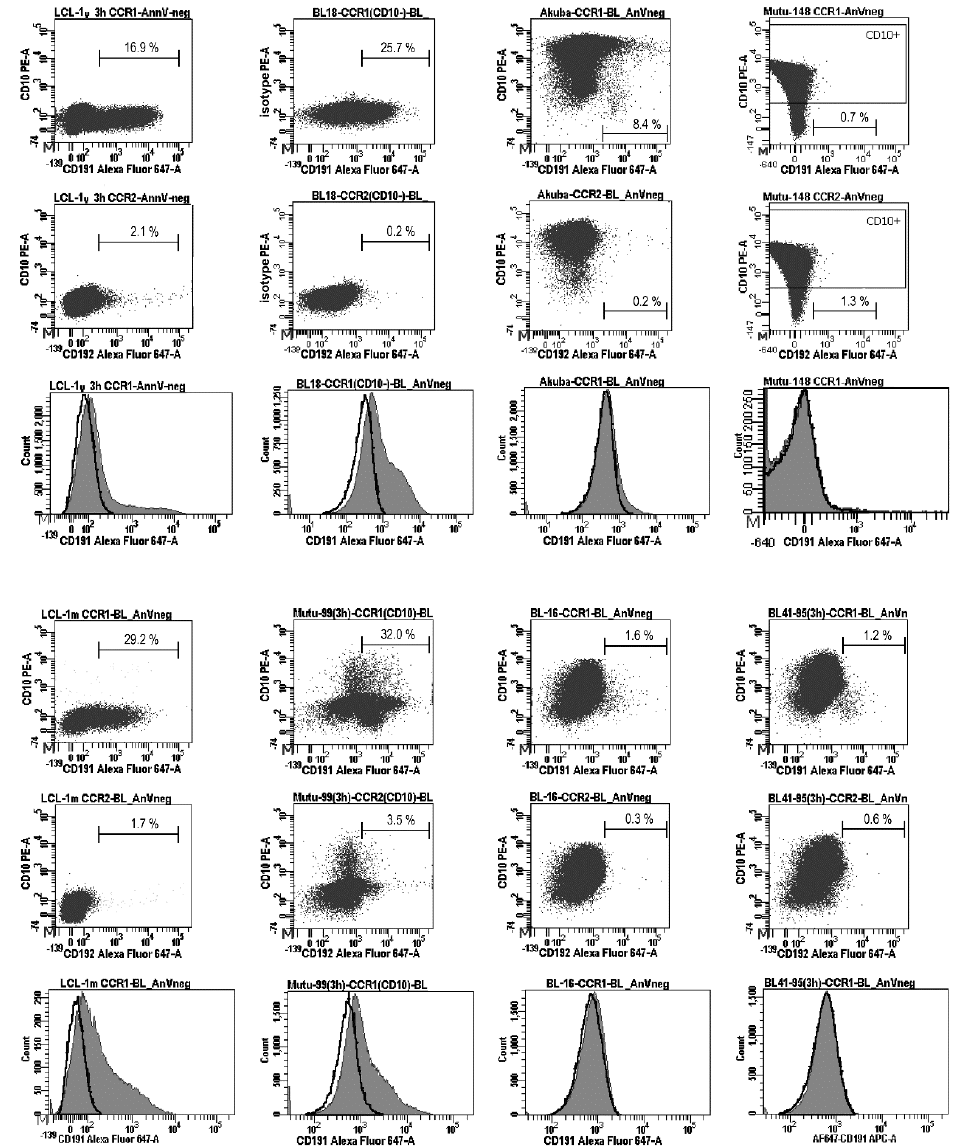
Figure 3. Analysis of the CCR1 cell surface expression in Burkitt lymphoma cell lines. The presence of CCR1 on the cell surface was analyzed after inducing receptor recycling (3 h of serum deprivation), using three-color flow cytometry. BL18 and Mutu cl.99 are the EBV-carrying type III BL cell lines; Akuba, BL41/95, and BL16 are the EBV-carrying type II BL cell lines; Mutu cl.148 is the EBV-carrying type I BL cell lines; LCL-1y and LCL-1m are the established in vitro LCLs, which have been cultured during approximately 1 year and 1–2 months, respectively. The dot plots show the cells stained with anti-CD10-PE, anti-CD191(CCR1)-Alexa Fluor 647, and anti-CD192(CCR2)-Alexa Fluor 647 antibodies; a minimum of 20,000 gated cells were analyzed; the threshold border was defined at 3.0% of the stained cells. Apoptotic cells (stained with annexin V-Horizon V450 or annexin V-PerCp-Cy5.5) and autofluorescent cells were excluded from the analysis. The anti-CD192(CCR2)-Alexa Fluor 647 antibodies did not detect CCR2 on the cell surface in BL cell lines nor in LCLs. The histograms show the vast majority of the CD191(CCR1)-stained cells (filled gray) shifted relative to the CD192(CCR2)-stained cells (bold lines) in LCLs and type III BL cell lines BL18 and Mutu cl.99; in the early passage type II BL cell line Akuba, only a small fraction of cells (~8.4%) are positive for CCR1. Representative results from two independent experiments are shown.